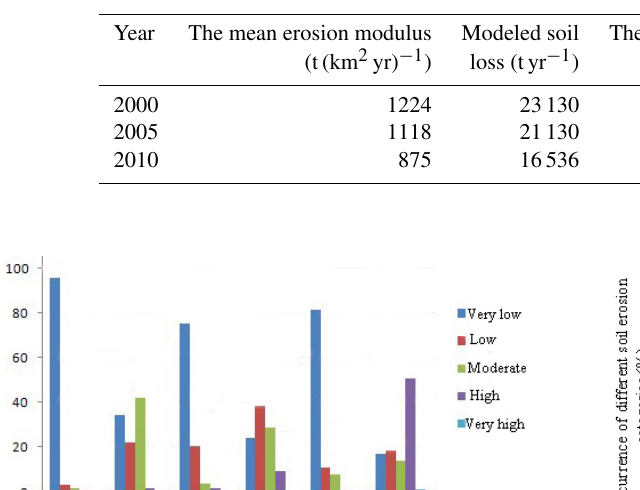
Table 3. Comparison of modeled and measured annual soil loss across the whole study catchment.